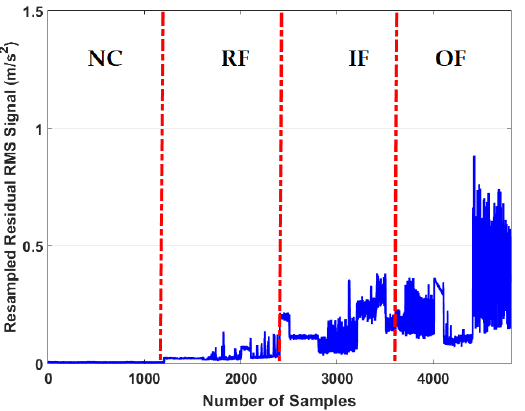
Figure 10. Resampled residual RMS signal using the MGPRLF-PI technique for the NC, RF, IF, and OF. Figure 11 validates the confusion matrix to test the crack identification accuracy us- ing the MGPRLF-PI + SVM.